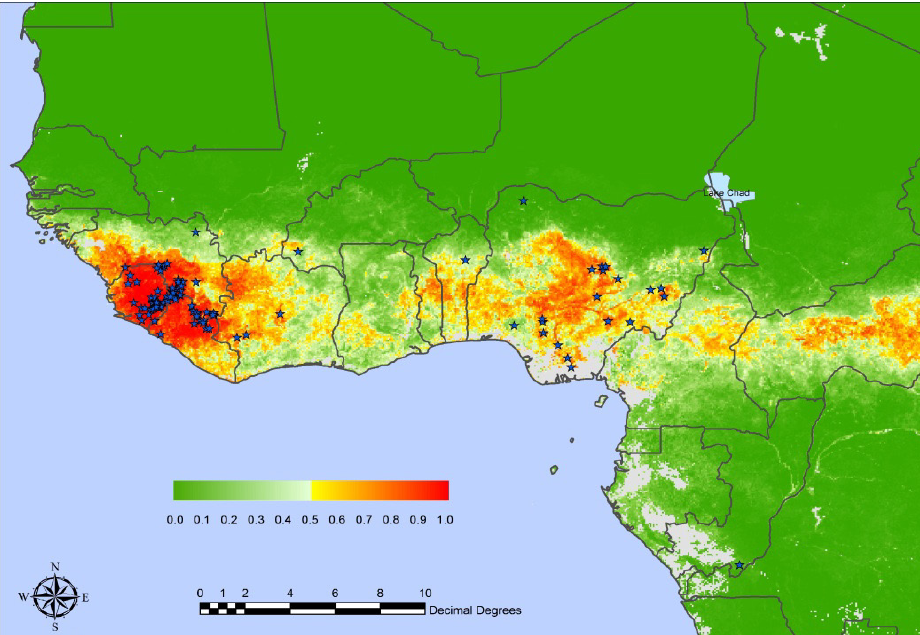
stars. The posterior probability color scale, from 0.0 (no risk) to 1.0 (highest risk) is shown as an inset. From E. Fichet-Calvet, D.J. Rogers [3] with